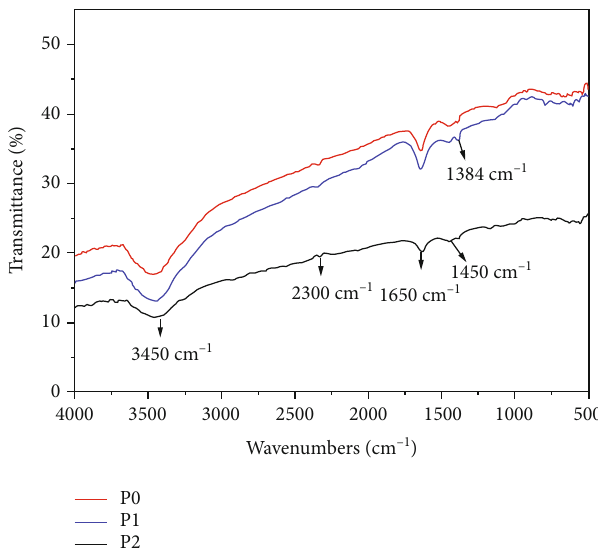
Figure 1: Fourier transform infrared spectroscopy for treated and normal carbon fi bers.